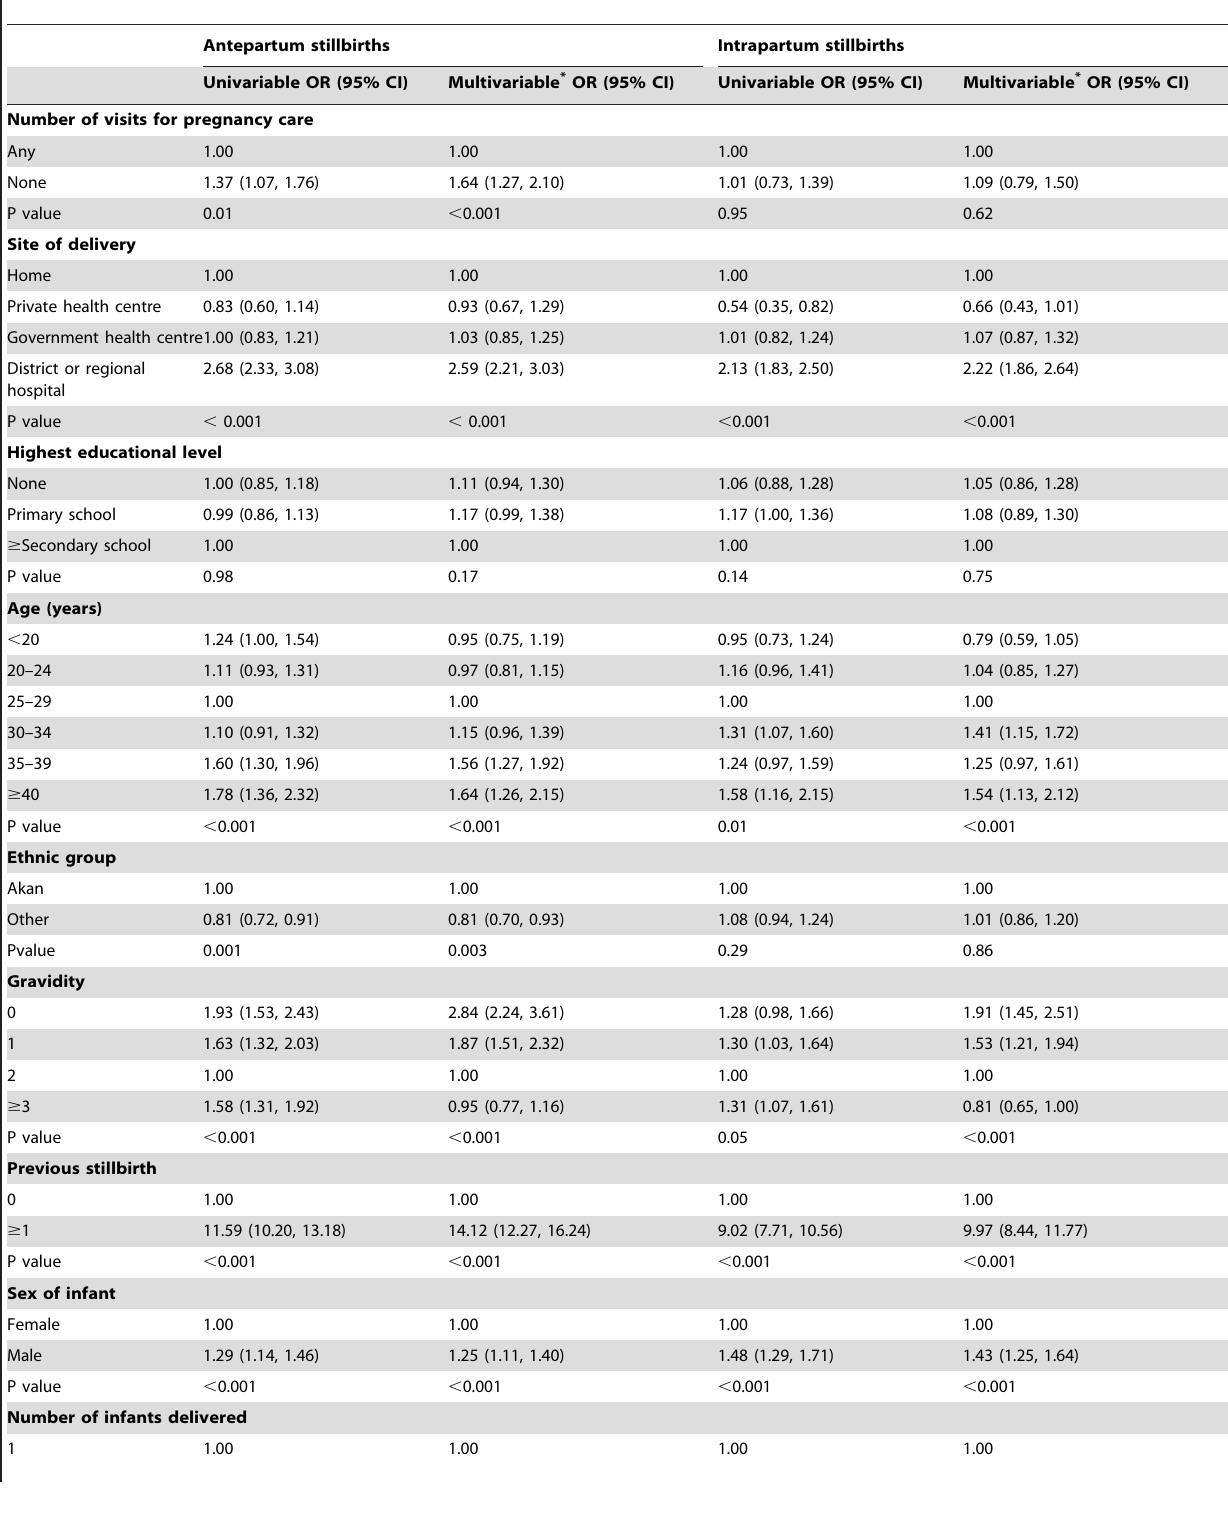
Table 2. Associations between stillbirths, maternal sociodemographic characteristics and obstetric history, 1 July 2003 to 30 September